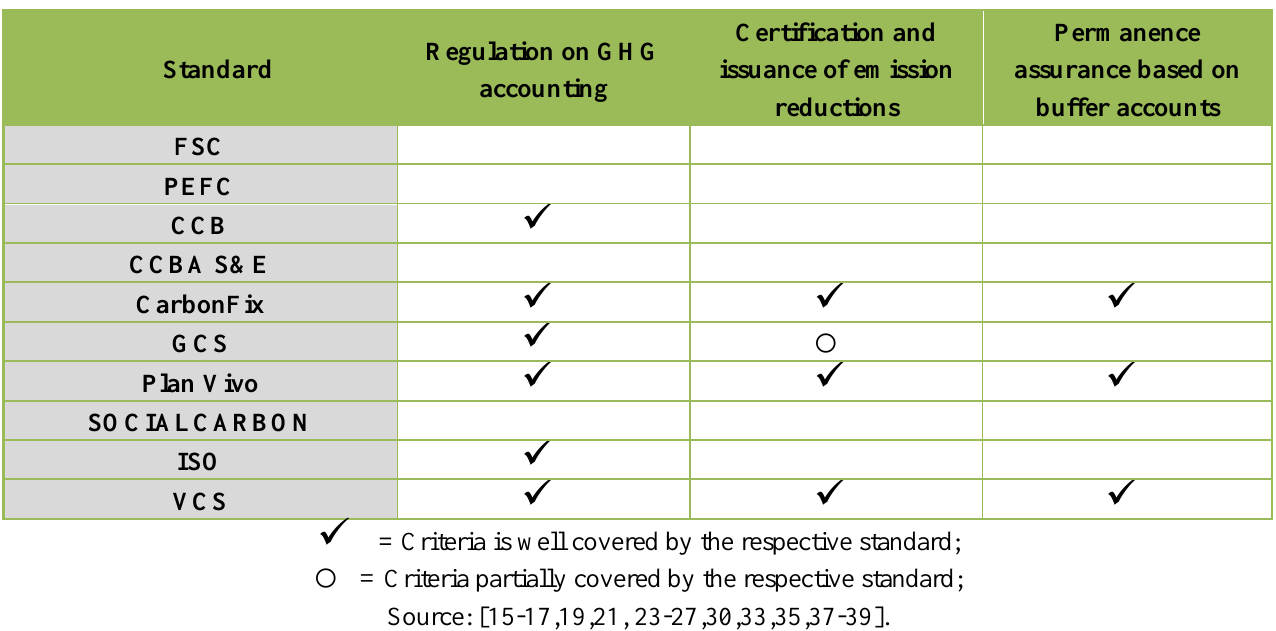
Table 5. Standards’ GHG accounting